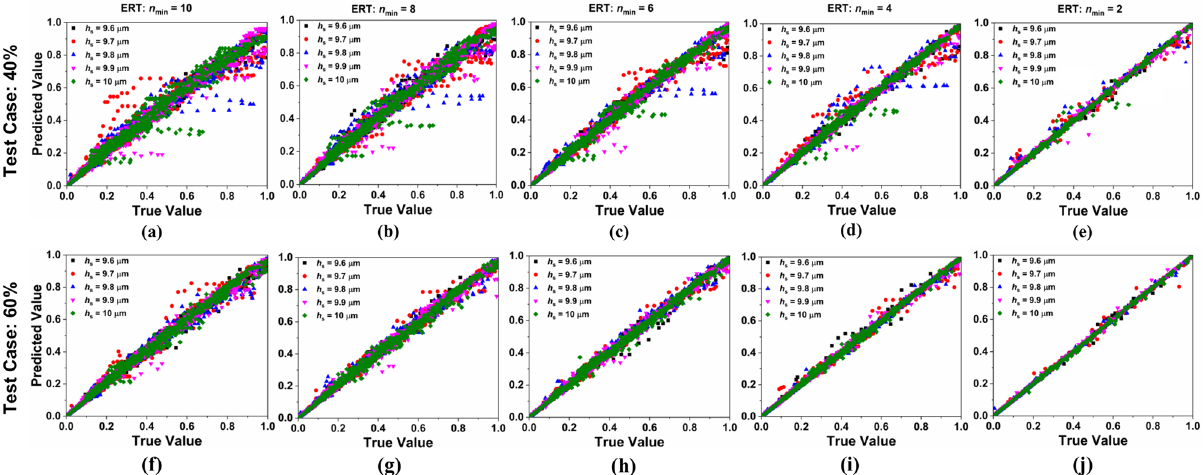
Figure 10. Values of absorption predicted by ERT model vs simulated values of absorption for various substrate thickness ( h s ) ( a ) n min = 10 for test case (TC)- 40 ( b ) n min = 8 for TC- 40 ( c ) n min = 6 for TC- 40 ( d ) n min = 4 for TC- 40 ( e ) n min = 2 for TC- 40 ( f ) n min = 10 for TC- 60 ( g ) n min = 8 for TC- 60 ( h ) n min = 6 for TC- 60 ( i ) n min = 4 for TC- 60 and ( j ) n min = 2 for TC- 60.